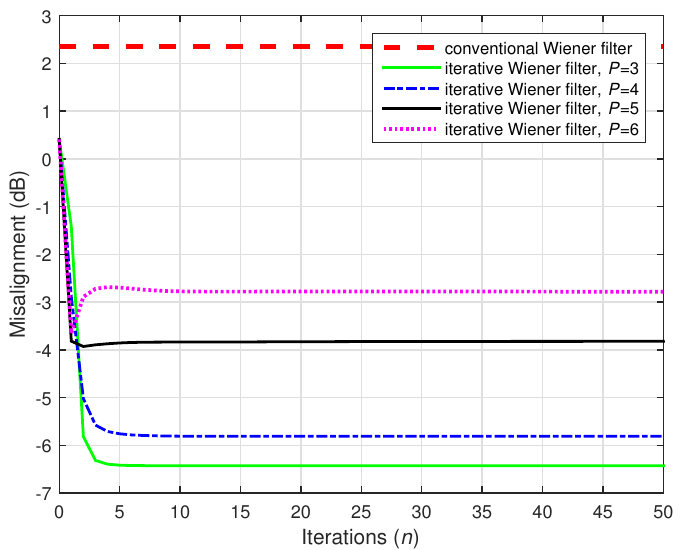
Figure 16. Performances of the conventional and iterative Wiener filters, using N = 10,000. The input signals were independent AR(1) processes, M = 4, L = 500, and SNR = 0